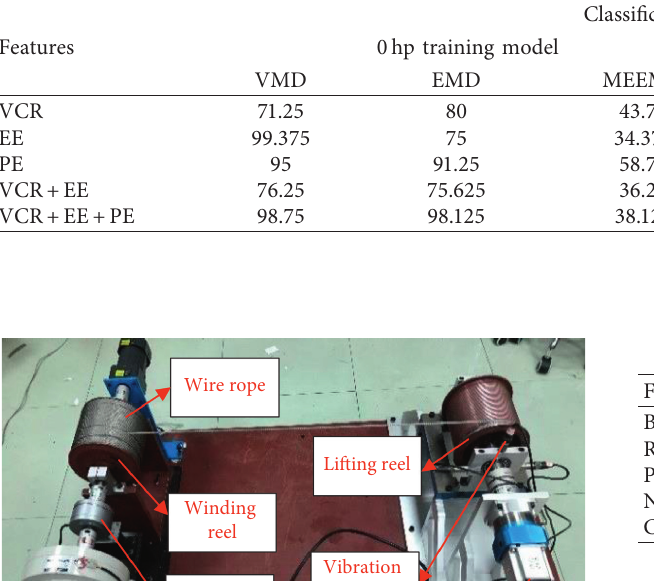
Table 5: The test results of 3hp under the training model of 0hp and 1hp (SVM). Features